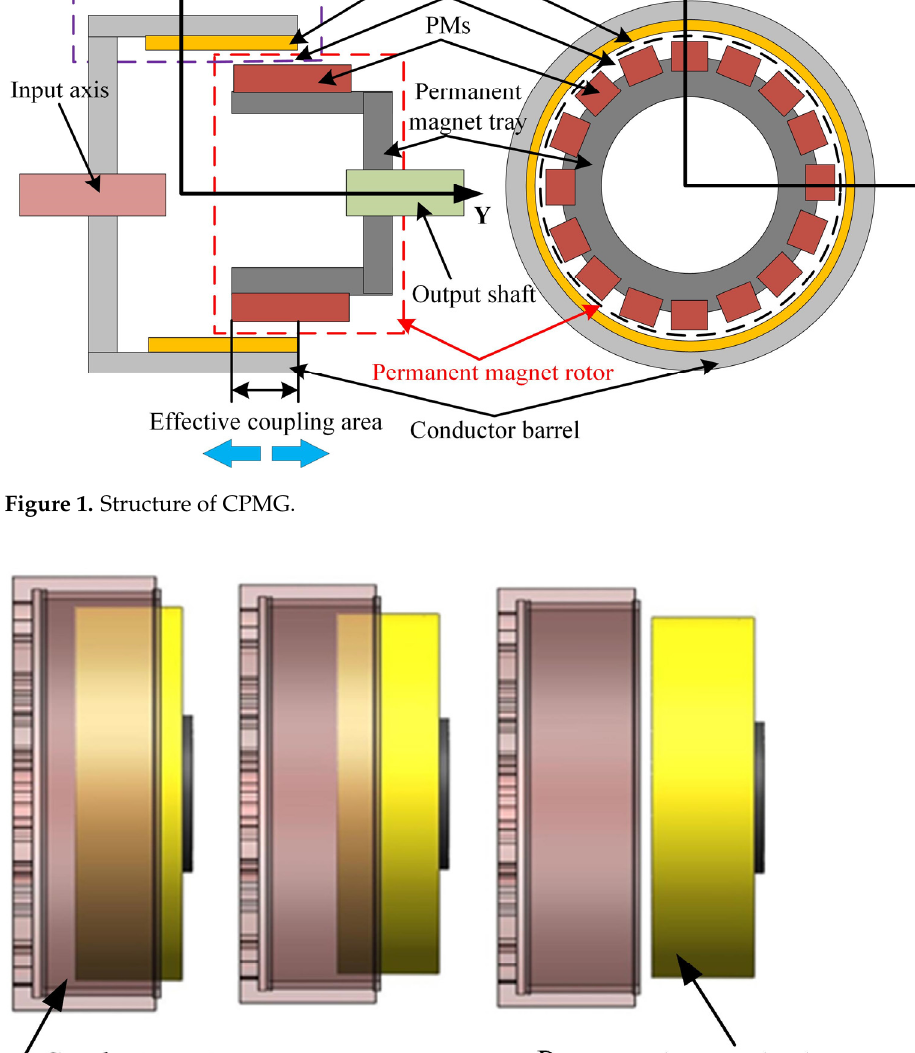
Figure 1. Structure of CPMG.